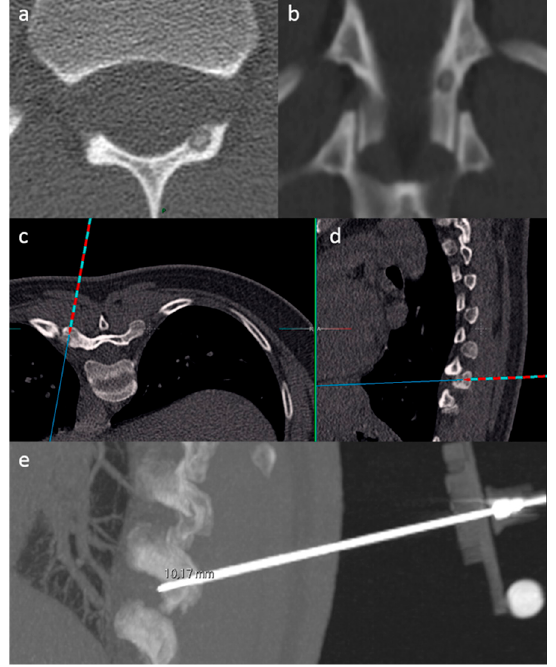
Figure 2. SIRIO-assisted needle positioning within an osteoid osteoma of the left lamina of a thoracic vertebra, in order to perform a biopsy procedure. Figures in ( a , b ) show CT images of the osteoid osteoma. Axial ( c ) and sagittal ( d ) reconstructions of the virtual 3D model show the needle trajectory to reach the lesion. The sagittal reconstruction in ( e ) confirms the correct positioning of the needle within the lesion; notice the needle tool with a passive sphere included in the CT scan (lower right).